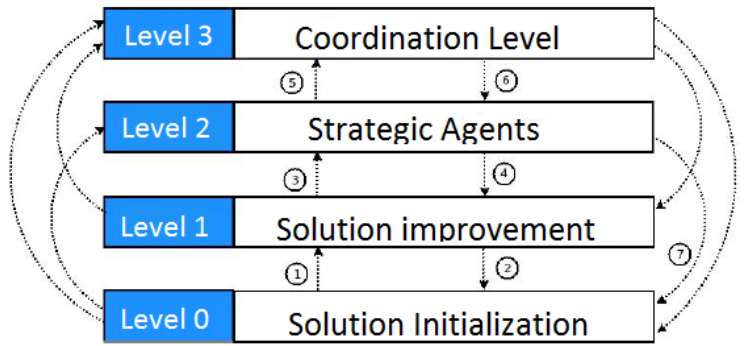
Figure 1. The MAGMA architecture, adapted from